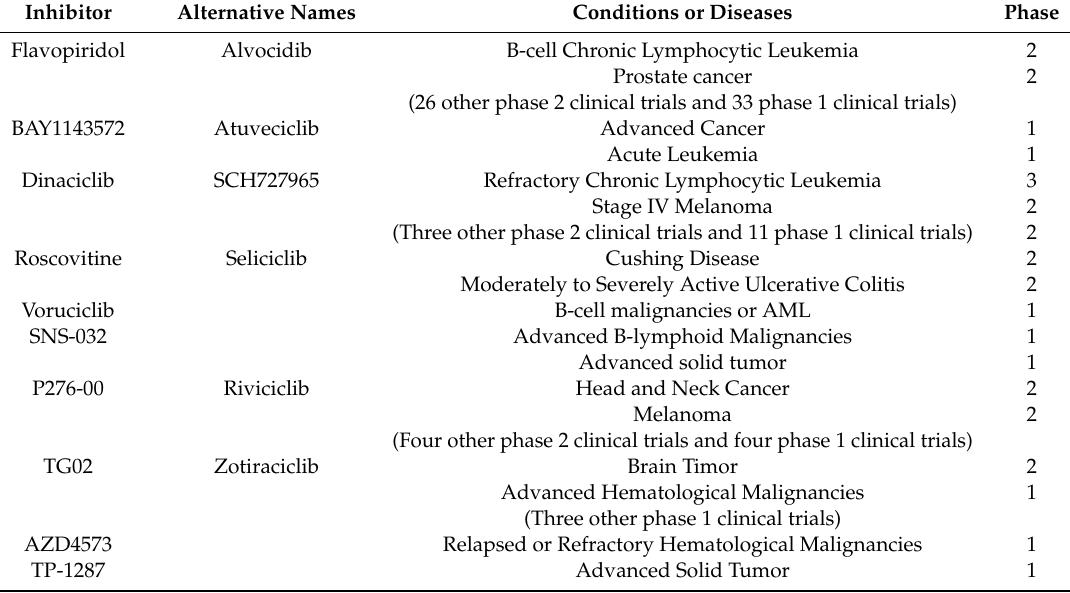
Table 3. Cdk9 inhibitors enrolled in clinical trials. (https: // clinicaltrials.gov).